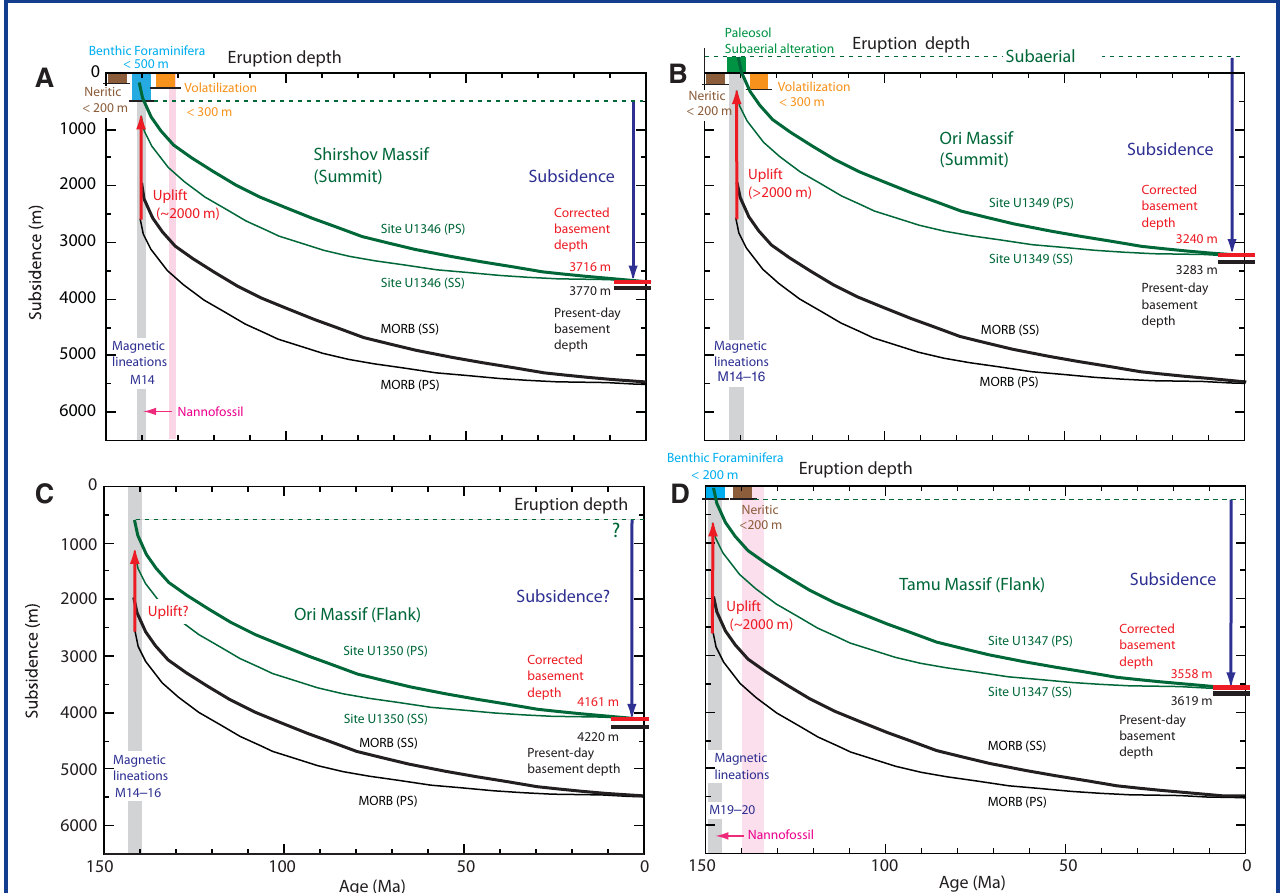
Figure 6. Subsidence curves calculated for Expedition 324 Sites. [A] Site U1346 (Shirshov Massif summit). [B] Site U1349 (Ori Massif summit). [C] Site U1350 (Ori Massif flank). [D] Site U1347 (Tamu Massif flank). Colored curves = extrapolated site depth at the time of eruptions, calculated by backtracking from the present depth (corrected for sediment loading; Crough, 1983) using thermal subsidence models. PS = Parsons and Sclater (1977) model, SS = Stein and Stein (1992) model. Paleodepth estimates from backtracking are compared with paleodepth indicators from Expedition 324 cores. Black curves = subsidence models for normal mid-ocean ridges, red arrow = difference between normal ridge and observed paleodepth, taken as the amount of uplift caused by volcano construction. Magnetic lineation ages are from Nakanishi et al. (1999) using the time scale of Gradstein et al.